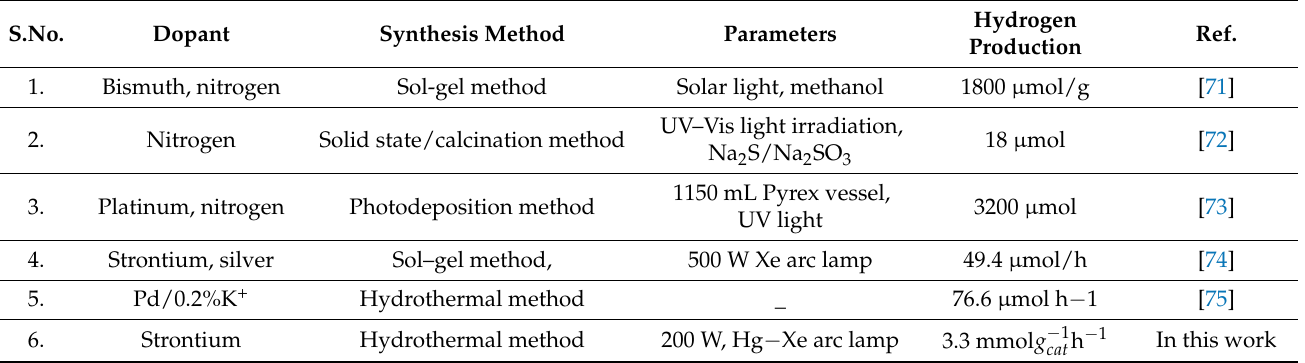
Table 2. Comparison of the photocatalytic performance of metal-doped TiO 2 synthesized by different